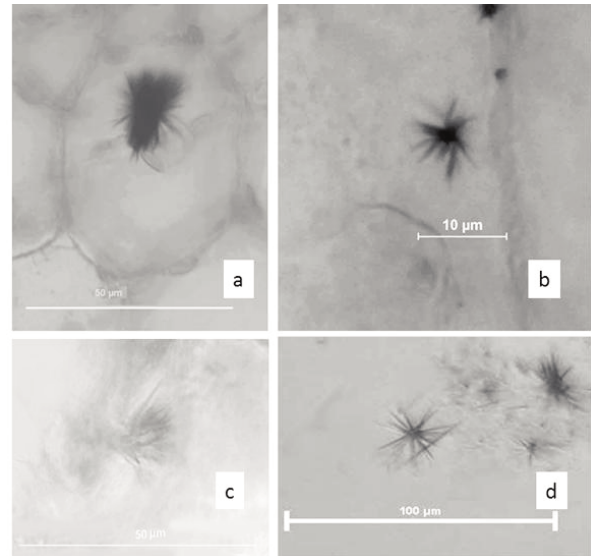
Fig. 1 - Rosette-shapedcrystals with caramel color inside cells of the stem's cortex of treated plants with salt concentra- tion 100 mM. A) in Draga B) in Spunta C) Pale Hesperidin crystal in the mesocarp layer of the peel of orange fruit, D) Tan naringin crystals in the juice of grapefruit; the resemblance between the two structures is